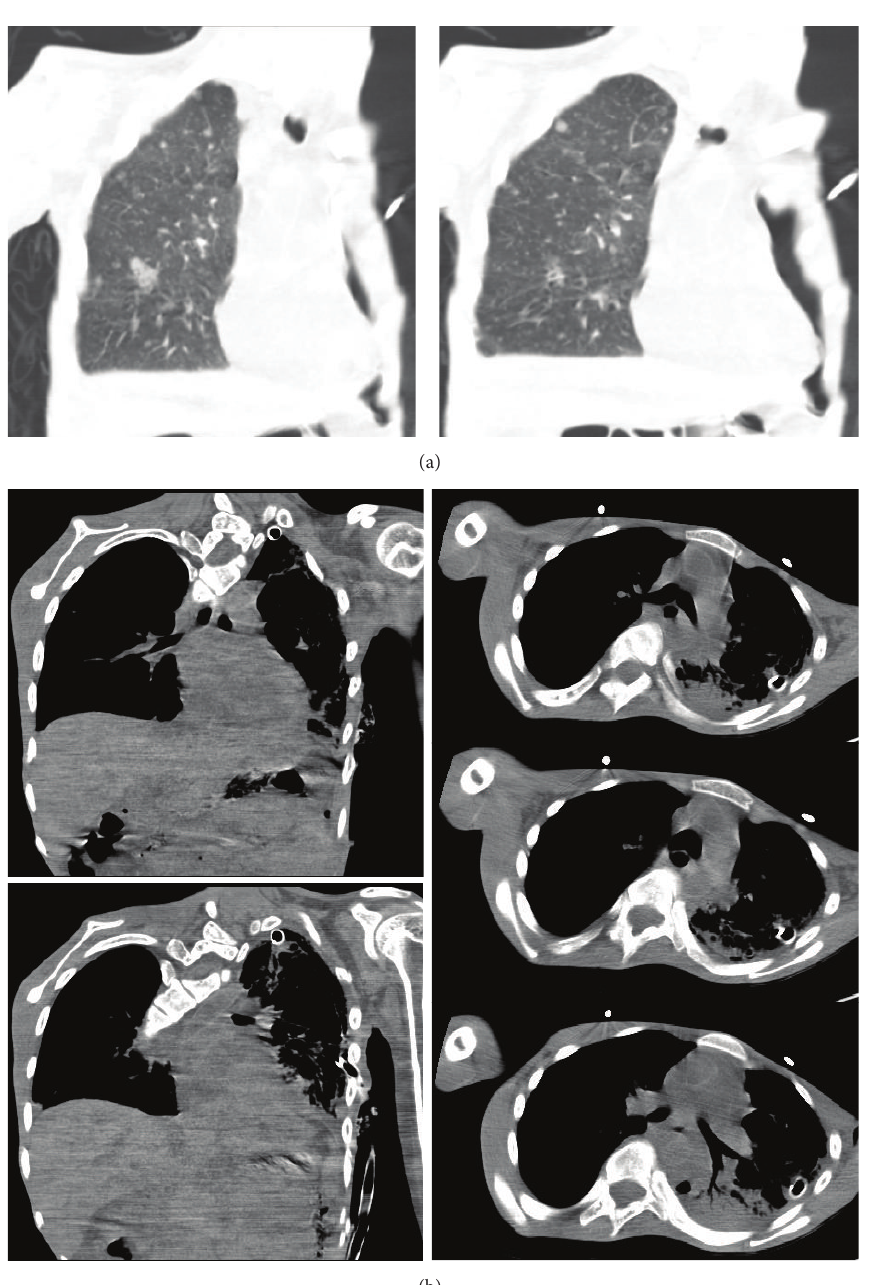
Figure 2: (a) Chest CT different cuts from lung showing right side multiple small nodules. (b) Mediastinal window showing no signs of air in the